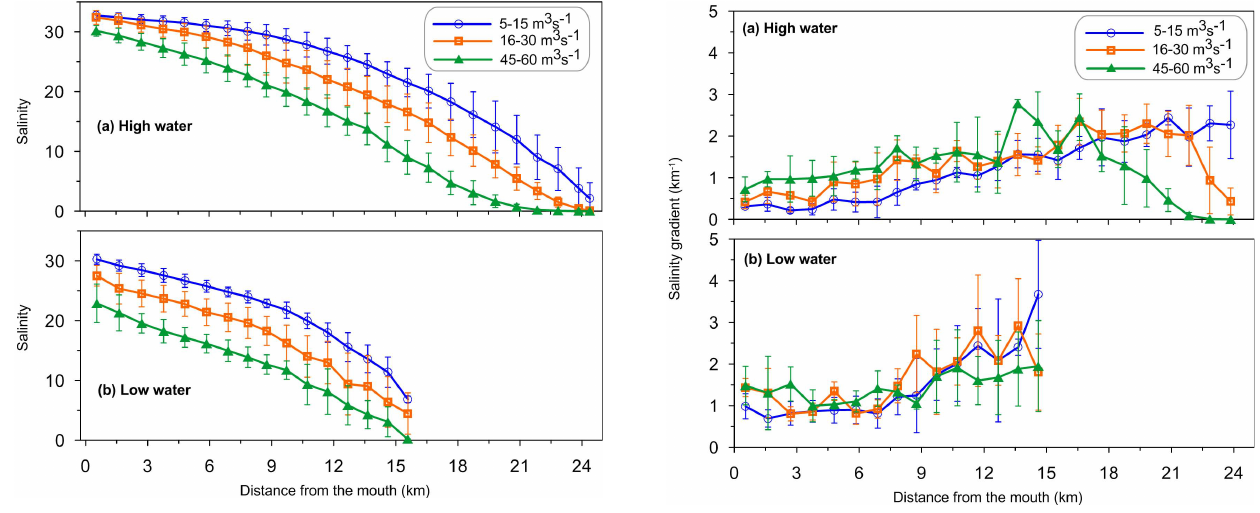
Fig. 3. Spatial variation in mean longitudinal salinity gradient along the Sumjin River Estuary at low and high tide under different river